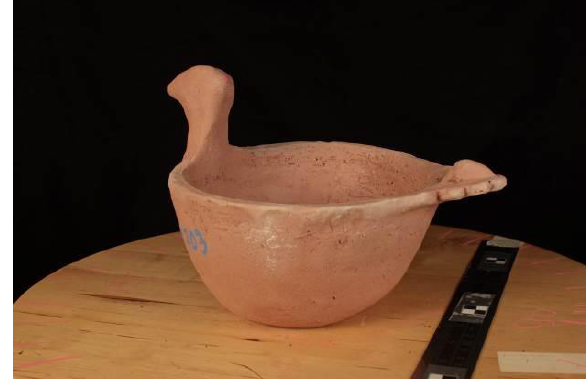
Figure 5: An image used to create the BF model